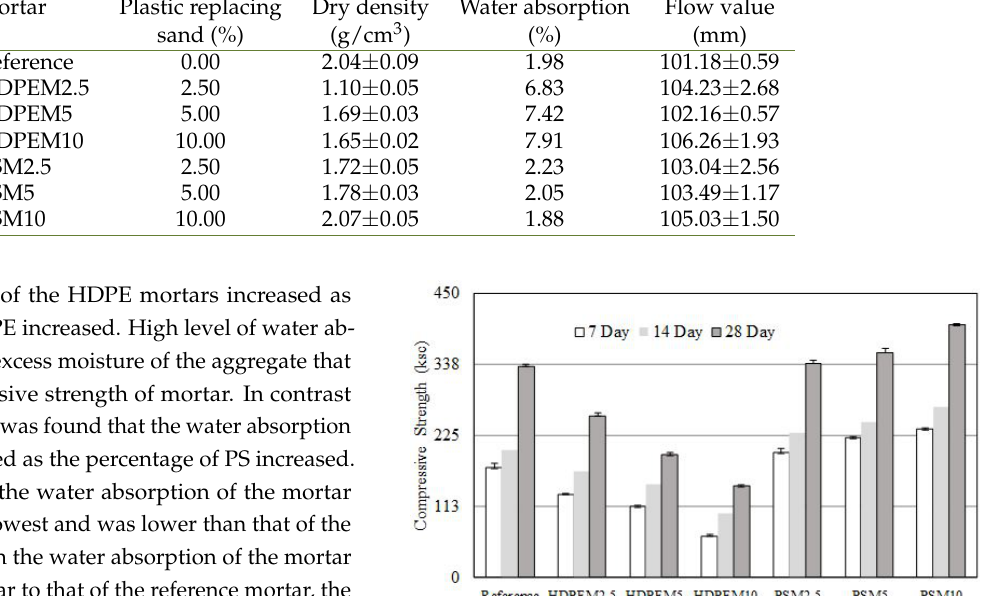
Table 2. Physical properties of the mortar samples Mortar Plastic replacing